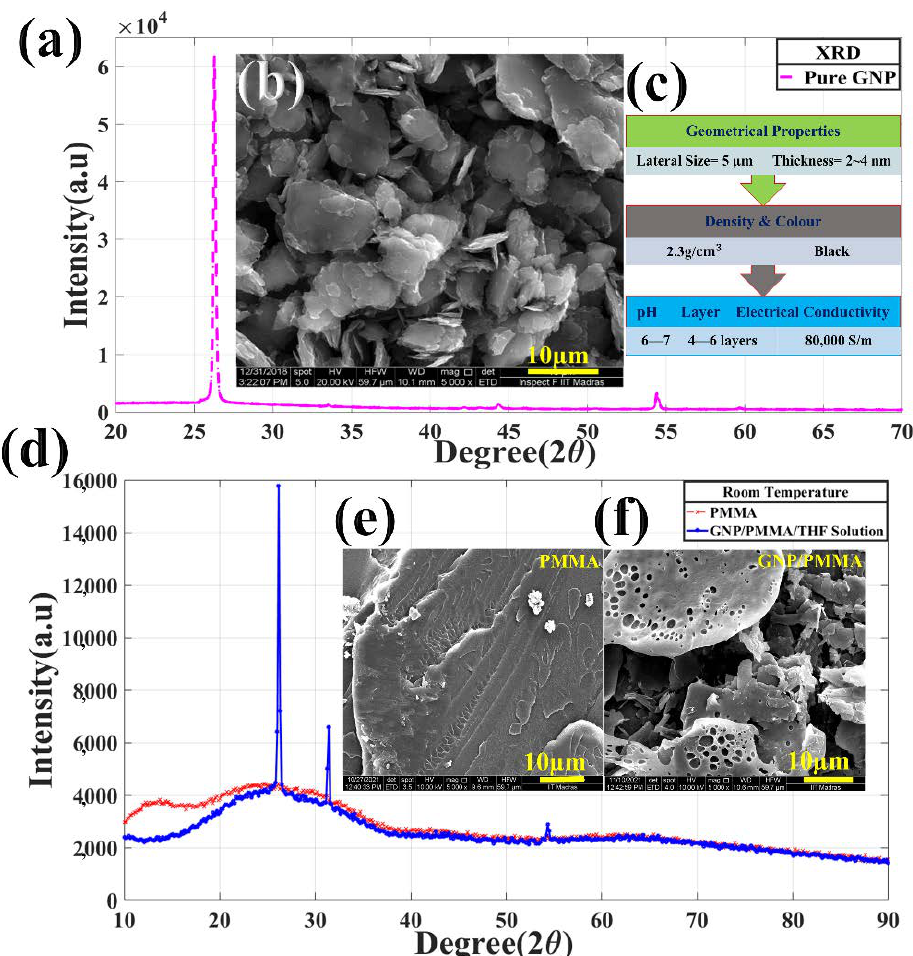
Figure 2. Experimental setup for thermal monitoring during tensile loading: ( a ) XRD of pure GNPs; ( b ) SEM image of GNPs; ( c ) properties of GNPs bought from (GRAPHENE LAB Ltd., London, UK); ( d ) XRD of pure PMMA and GNPs/PMMA/THF solution; ( e , f ) SEM image of PMMA and PMMA- doped GNPs.